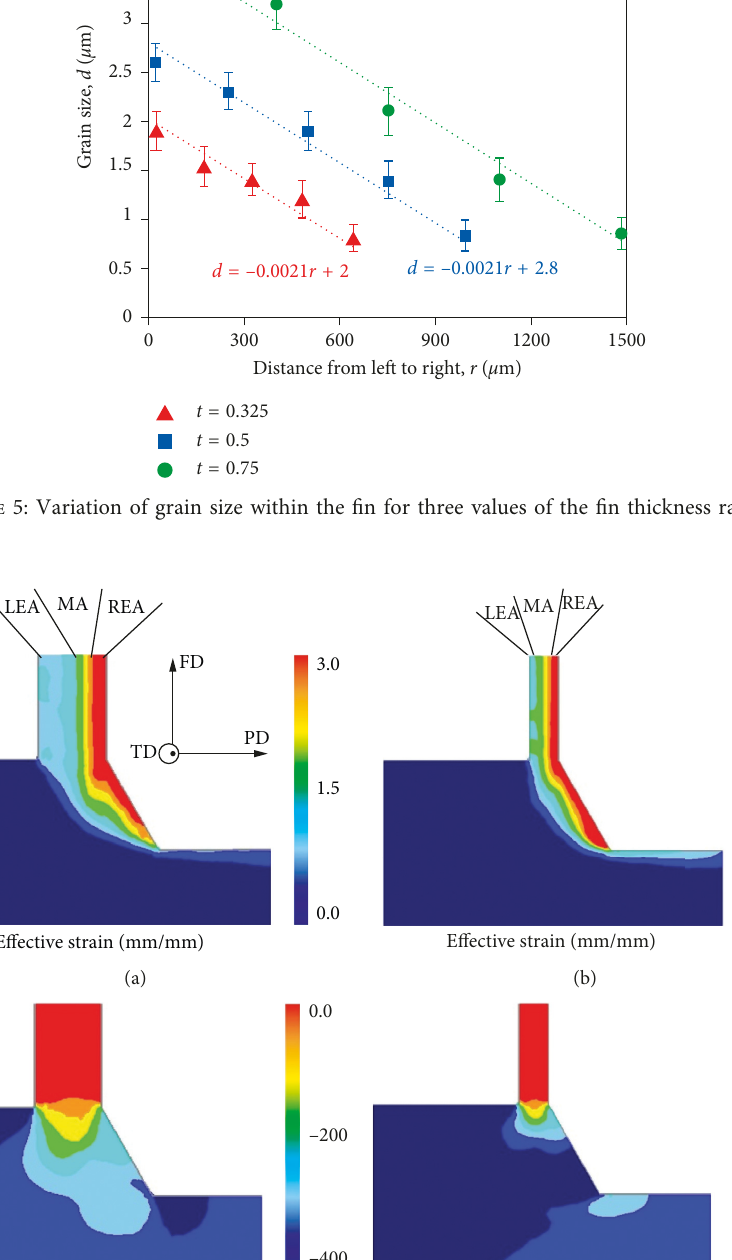
0 . 75 and for (b) and (d) t 0 . 325. The maximum (cid:31) (cid:31)